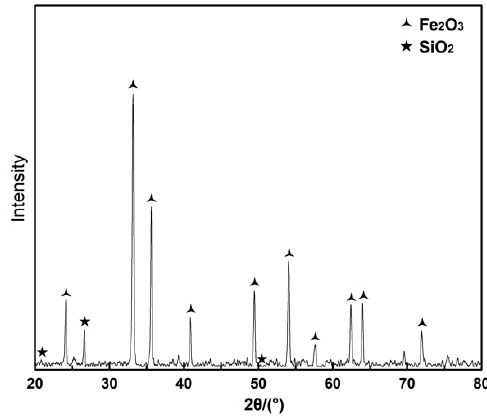
Figure 2. XRD analysis of iron ore.